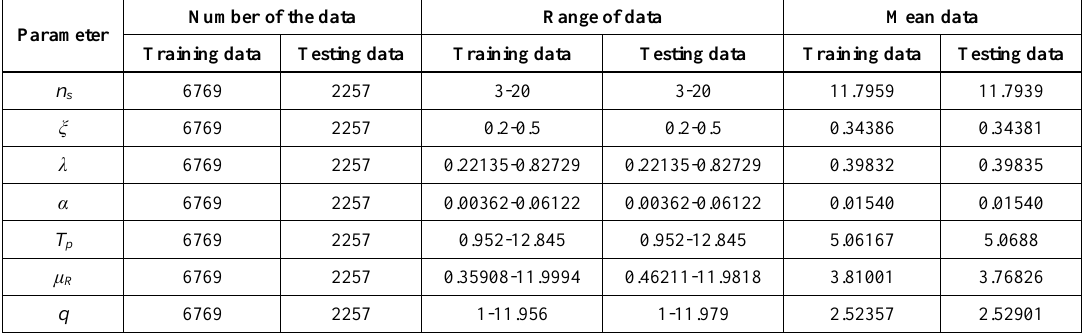
Table 3. Range of the data